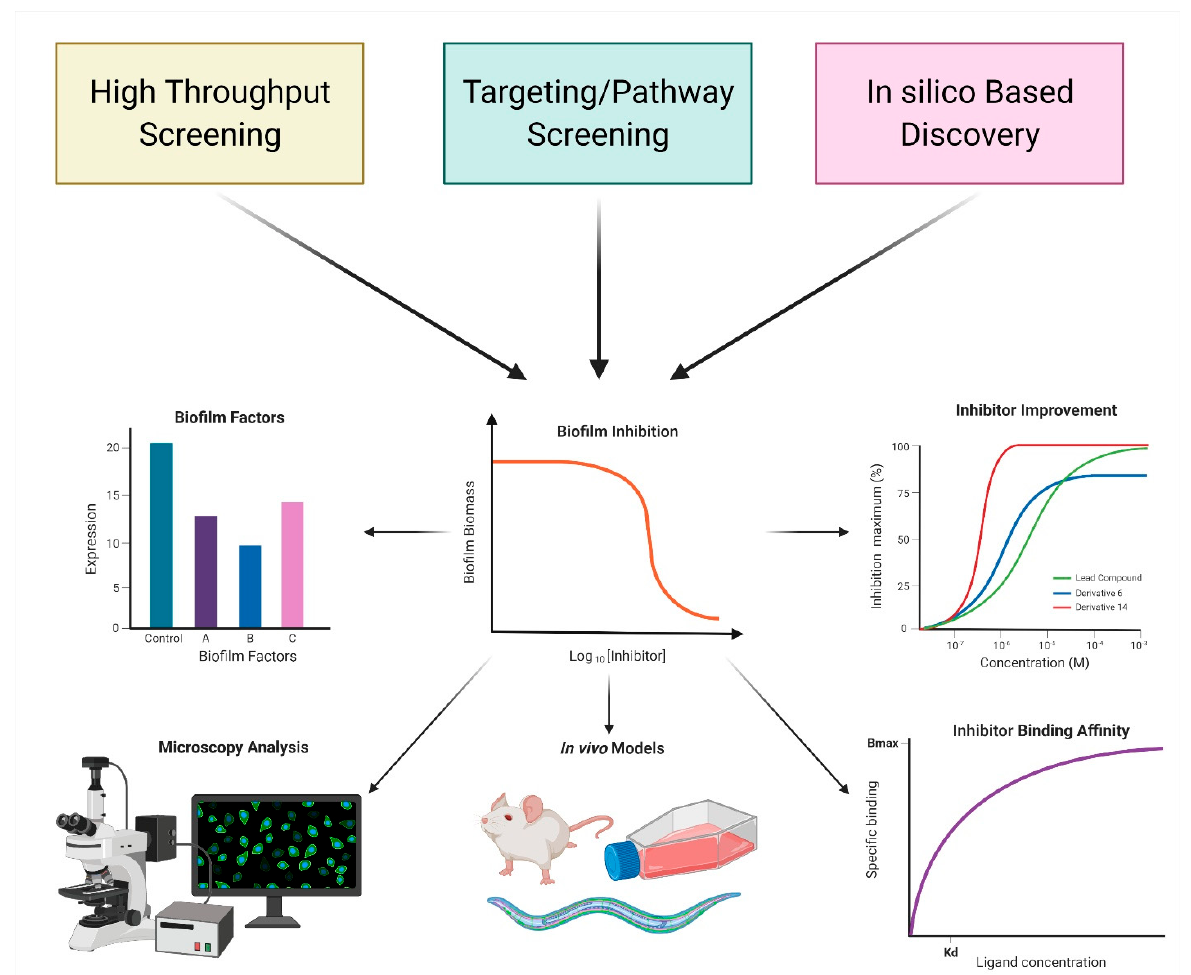
Figure 2. Overview of approaches used identification of biofilm inhibitors. Screening-based and in silico discovery approaches are commonly used. After initial discovery, typically using biofilm biomass or biofilm gene expression as a readout, additional studies are performed to determine the impact of these inhibitors on biofilm matrix production, biofilm structure, biofilm driven infection, inhibitor binding affinity, and inhibitor improvement. Such studies provide an insight into the mechanism of action of the identified compounds. Created with BioRender.com.